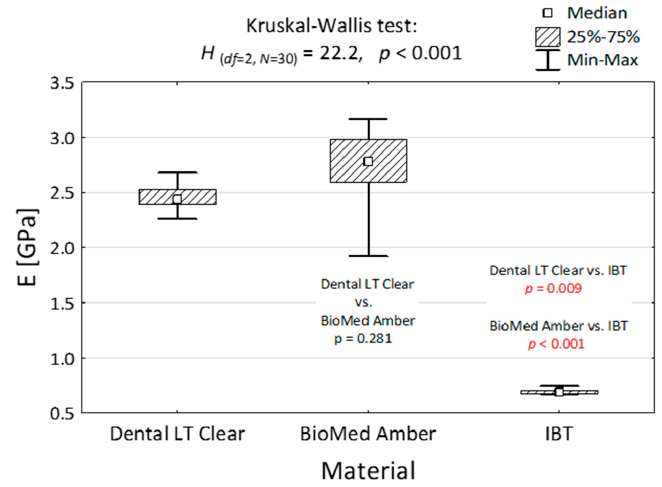
Table 3. Analysis of variance according to Kruskal–Wallis test on compression modulus [MPa].